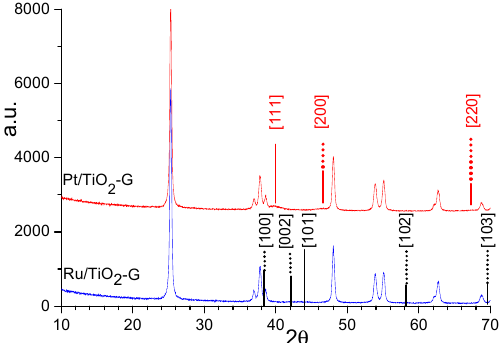
Figure 1. XRD patterns of Pt / TiO 2 -G and Ru / TiO 2 -G catalysts used for continuous experiments.